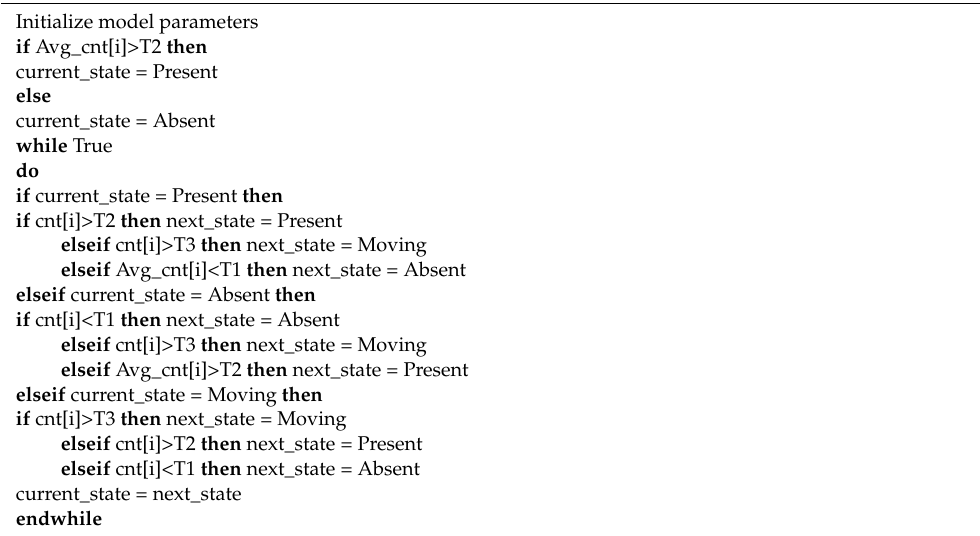
Algorithm 1 Presence detection based on state machine